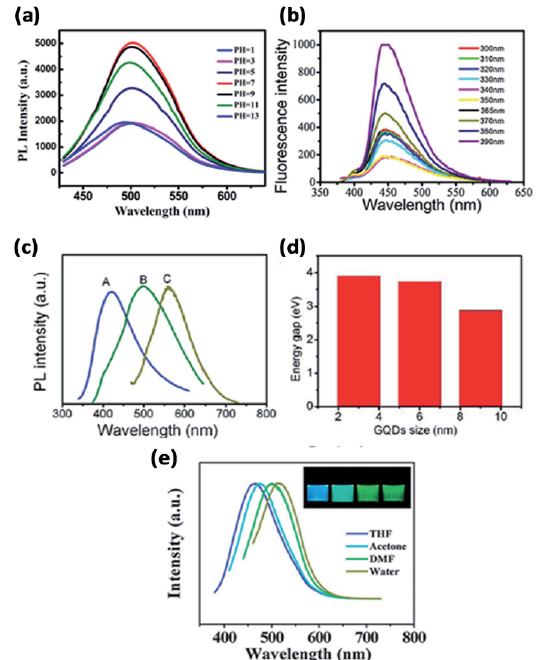
Figure 6. Fluorescence spectra of GQDs at ( a ) different pH levels, ( b ) different excitation wavelengths, ( c ) and ( d ) different sizes of GQDs and bandgap energy, and ( e ) different solvents. Reprinted from [23]; Published by The Royal Society of Chemistry.